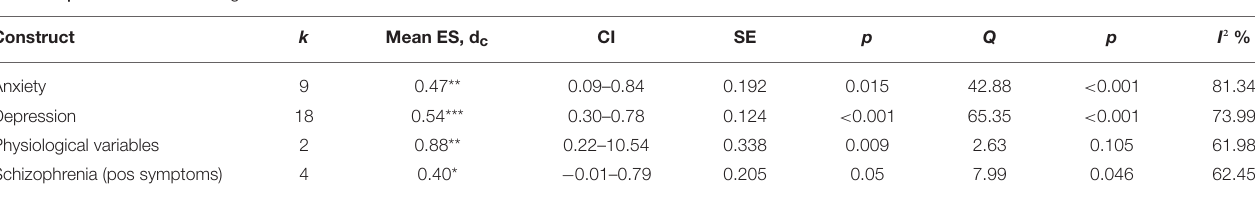
TABLE 3 | Effect sizes according to sub-clusters.